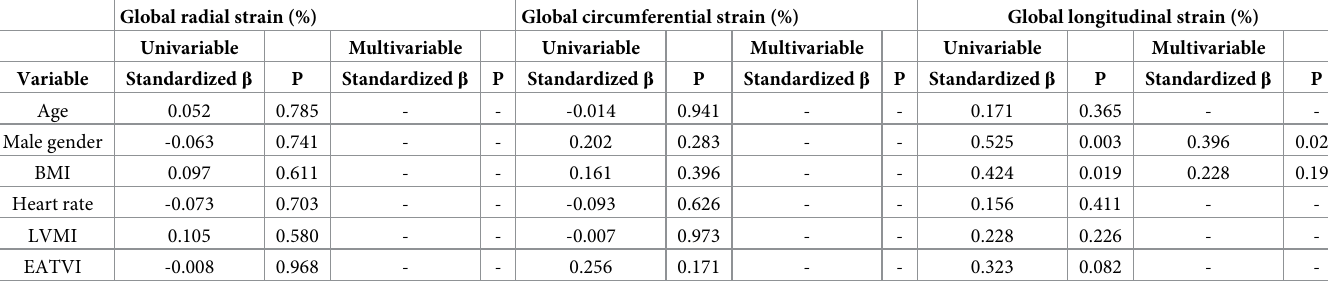
Table 5. Univariable and multivariable linear regression models for RV myocardial strain amateur marathon runners (n = 30). Global radial strain